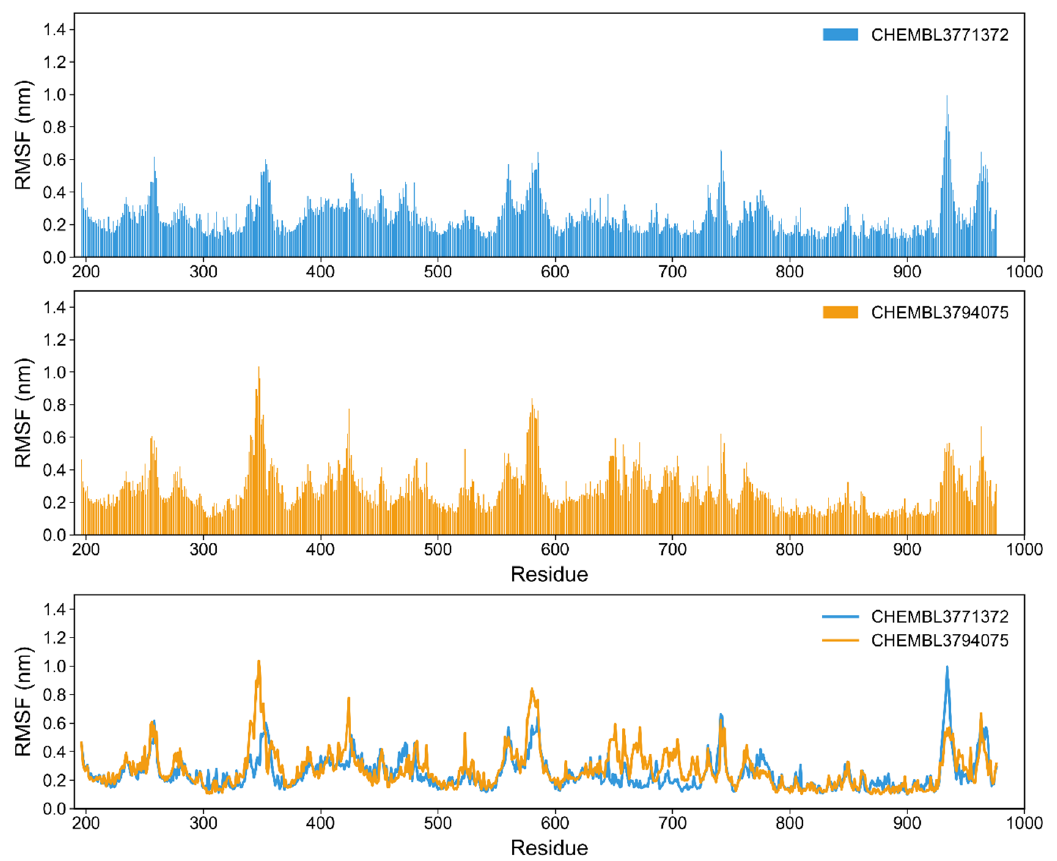
Figure 14. RMSF plots of the EZH2 for the simulations with both selected molecules, CHEMBL3771372 and CHEMBL3794075. Residue IDs in the x -axis refer directly to the sequence numbers associated with